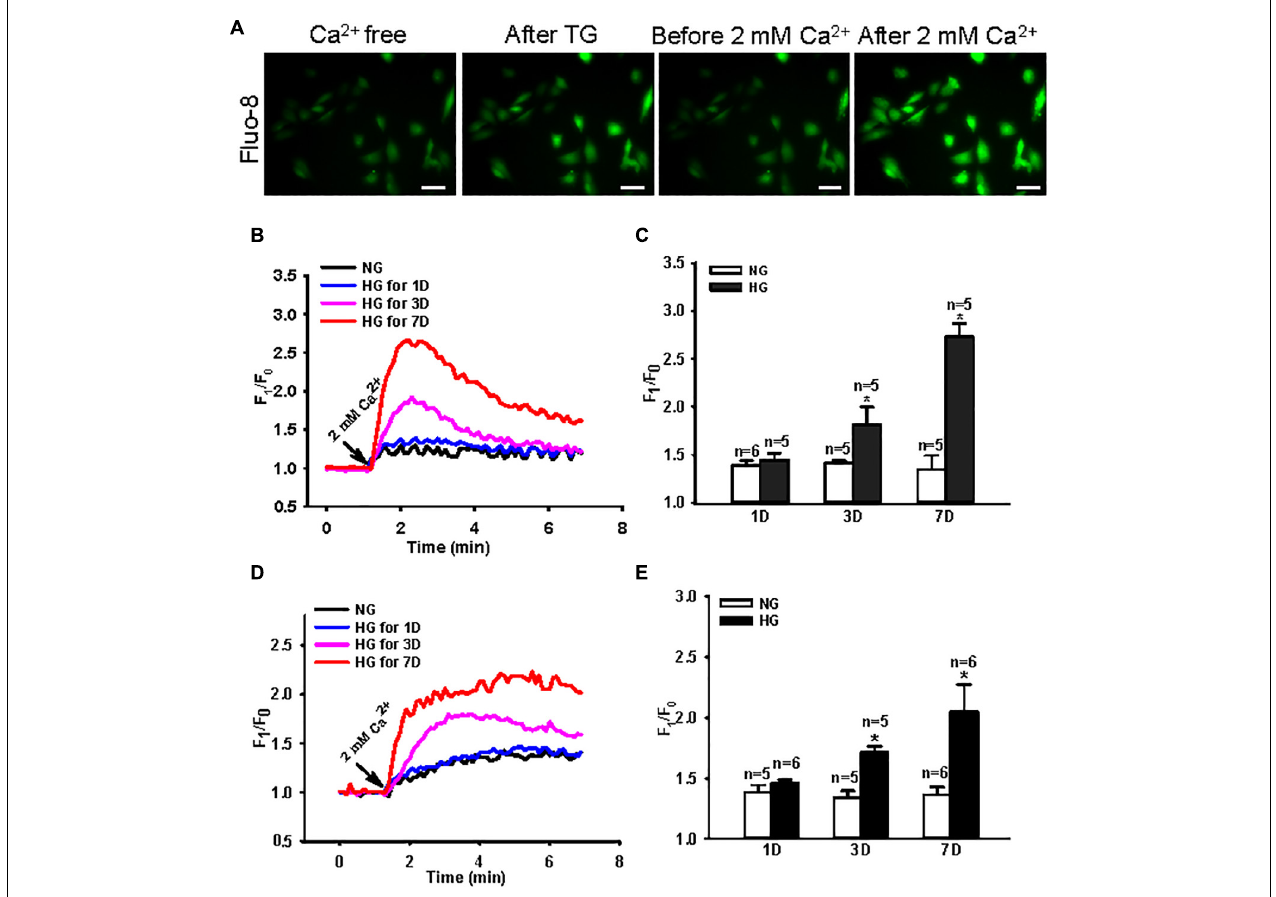
FIGURE 1 | Effect of high glucose (HG) culture medium on store-operated Ca 2 + entry (SOCE) in MUS-M1 cells. (A) SOCE was evoked by a classic “Ca 2 + added back” protocol. Images showing fluorescence intensity indicating the change of transient intracellular Ca 2 + concentration ([Ca 2 + ] i ). Scale bars, 10 µ m. Representative traces (B,D) and summarized data (C,E) showing the change in [Ca 2 + ] i (SOCE) evoked by extracellular application of 2 mM Ca 2 + after the treatment of 2 µ M thapsigargin (TG) (B,C) or 100 µ M carbachol (D,E) for 20 min in Ca 2 + -free solution to deplete internal Ca 2 + stores in MUS-M1 cells cultured in normal glucose (NG, 5.6 mM D -glucose + 20 mM α -mannitol) or HG (25 mM D -glucose) medium for 1, 3, and 7 days. Values are shown as the mean ± SEM ( n = 5–6); * P < 0.05, NG vs. HG on the same